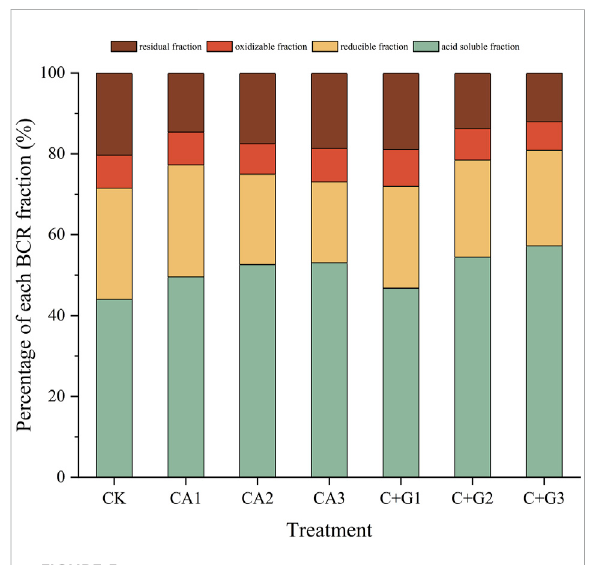
FIGURE 5 VariationofsoilCdspeciesundersinglecitricacidappliesand in combination with